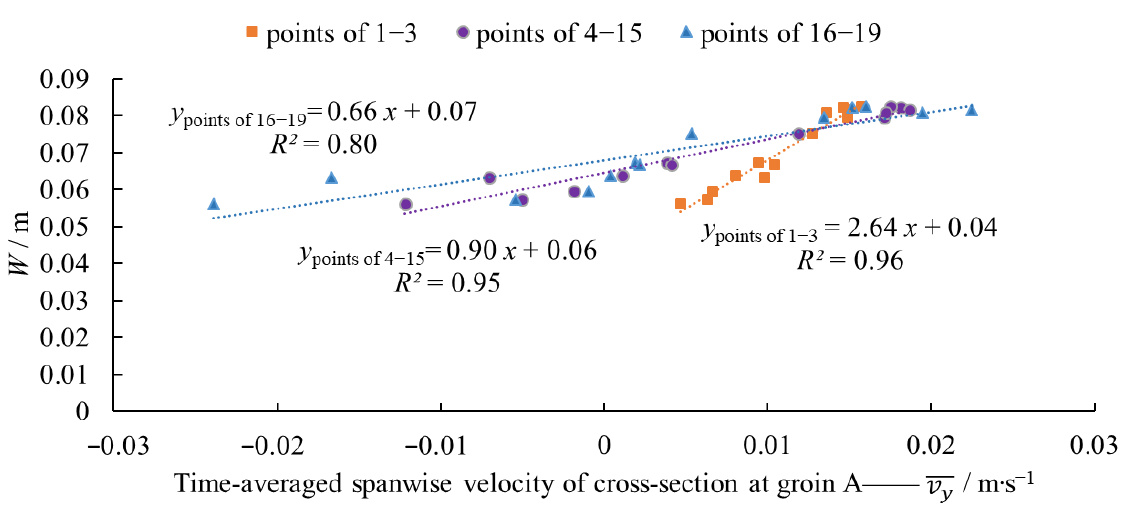
Figure 11. Relationship between the time-averaged spanwise velocity ( v y ) of observed points along the cross-section through Groin A and the width of the recirculation zone ( W ) behind Groin A.